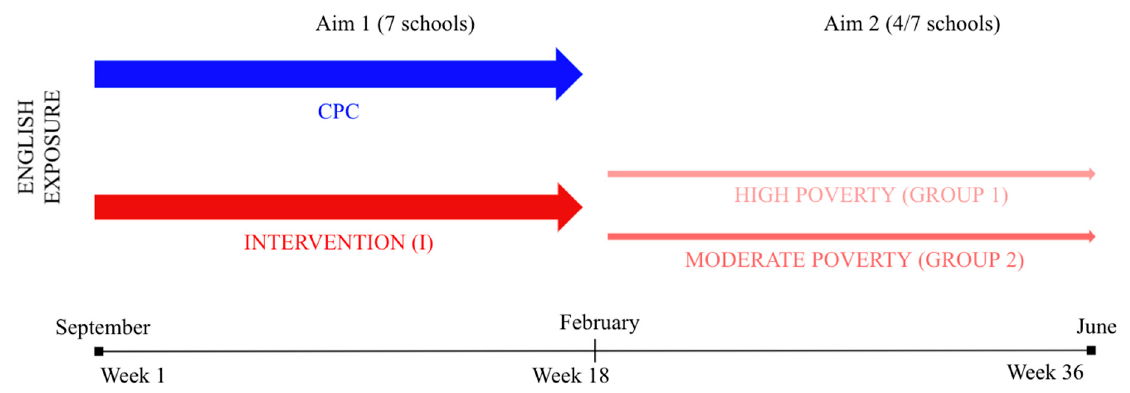
Figure 1. Outline of study design, I, SparkLing TM Intervention; CPC, current practice comparison.